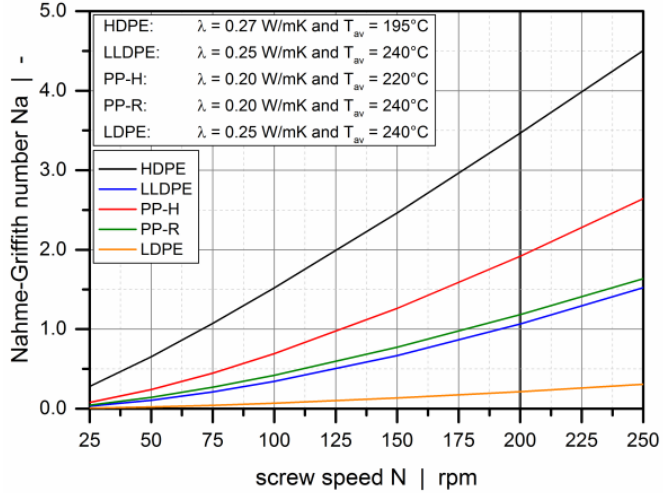
Figure 4. The Nahme–Griffith number as a function of screw speed for all materials.